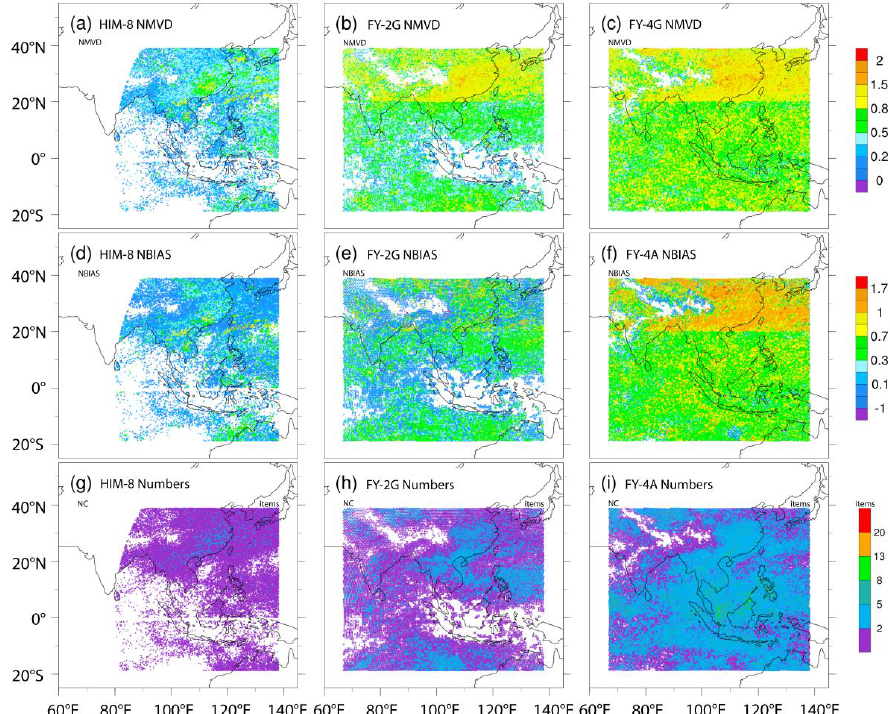
Figure 10. Same as Figure 9, but for mid-level IR AMVs averaged.